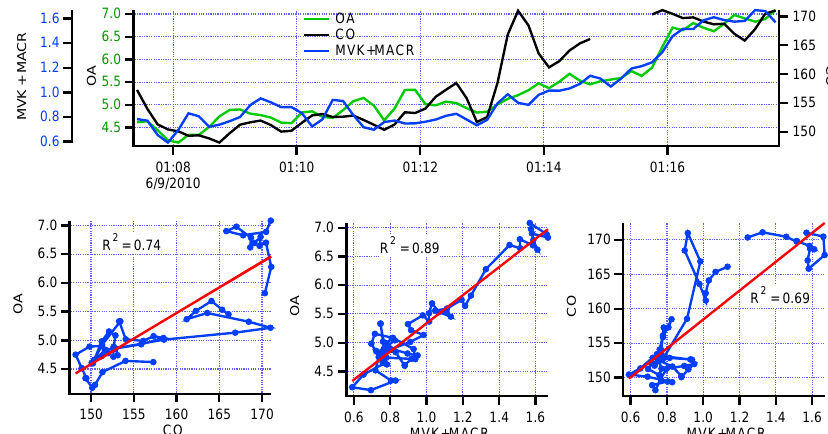
Figure 5. Flight 608b T1 transect. Same format as Fig. 4.